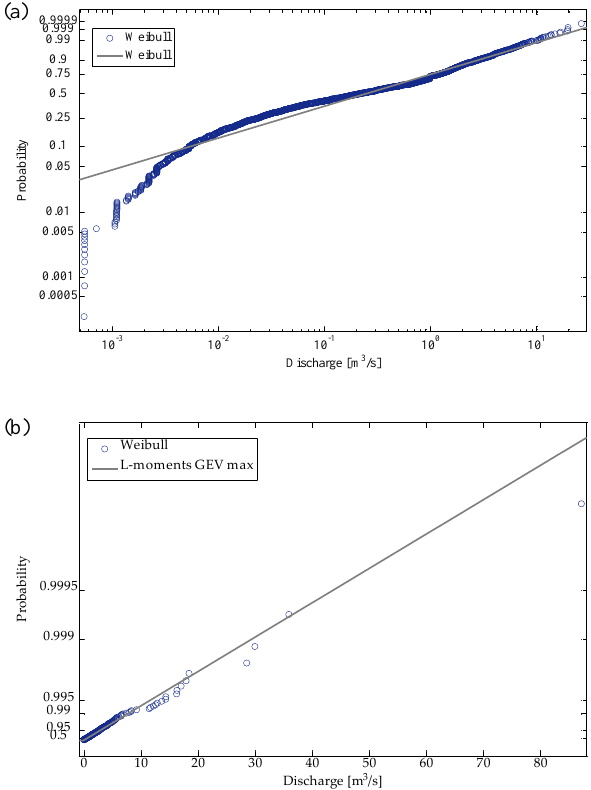
Fig. 7. Fitted Conditional Frequency Distribution F X 0 nz =Pr( X 0 ≤ x 0 | X 0 6= 0) for sites n. 5 (a) (logarithmic representation) and n. 3 (b) . The best distributions are the Weibull distribution for site n. 5 (a) and GEV max with parameters obtained with the L-moment method for site n. 3 (b)